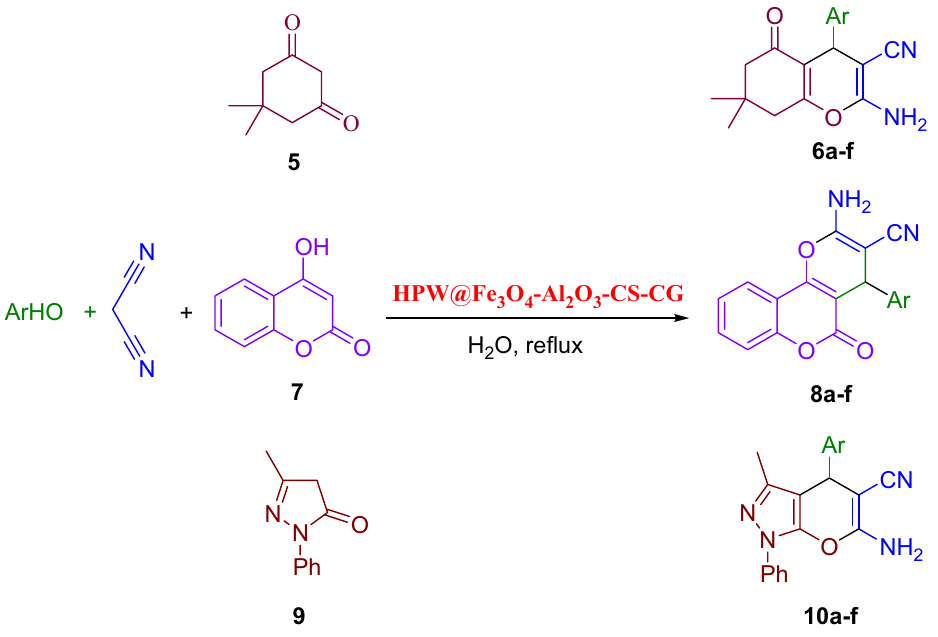
Figure 4. Synthesis of 2-amino-4 H -chromene derivatives using HPW@Fe 3 O 4 –Al 2 O 3